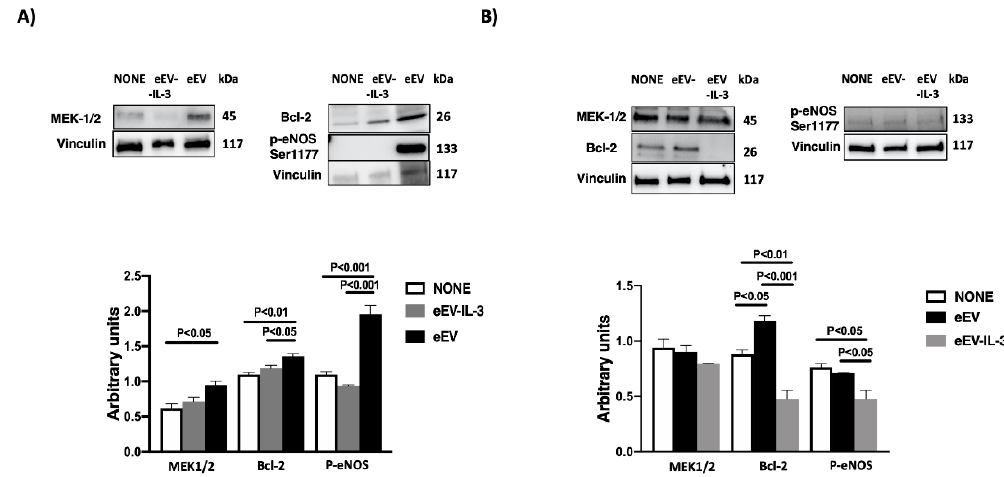
Figure 6. Effects of eEV and eEV-IL-3 on cardioprotective pathway. ( A ) Westen blot analysis of eEV and eEV-IL-3 in vitro treatment (transwell experiments). The expression of MEK1/2, p-eNOS, and B-cell-lymphoma-2 (Bcl-2) was evaluated in H9c2 cells exposed to H/R conditions and eEV or eEV-IL-3 treatment, normalized to vinculin. Untreated cells served as internal control (NONE) ( n = 3). MEK1/2: p < 0.05 NONE vs. eEV ( n = 4); Bcl-2: p < 0.05 eEV vs. eEV-IL-3; p < 0.01 NONE vs. eEV ( n = 3); p-eNOS: p < 0.01 NONE vs. eEV and eEV vs. eEV-IL-3 ( n = 3). ( B ) Western blot analysis of eEV and eEV-IL-3 in vitro treatment. The expression of MEK1/2, p-eNOS, and Bcl-2 was evaluated in H9c2 cells directly exposed to H/R conditions and eEV or eEV-IL-3 treatment, normalized to vinculin. Untreated cells served as internal control (NONE). Bcl-2: p < 0.001 eEV vs. eEV-IL-3; p < 0.05 NONE vs. eEV; p < 0.01 NONE vs. eEV-IL-3; p-eNOS: p < 0.05 eEV vs. eEV-IL-3; p < 0.05 NONE vs. eEV-IL-3 ( n =